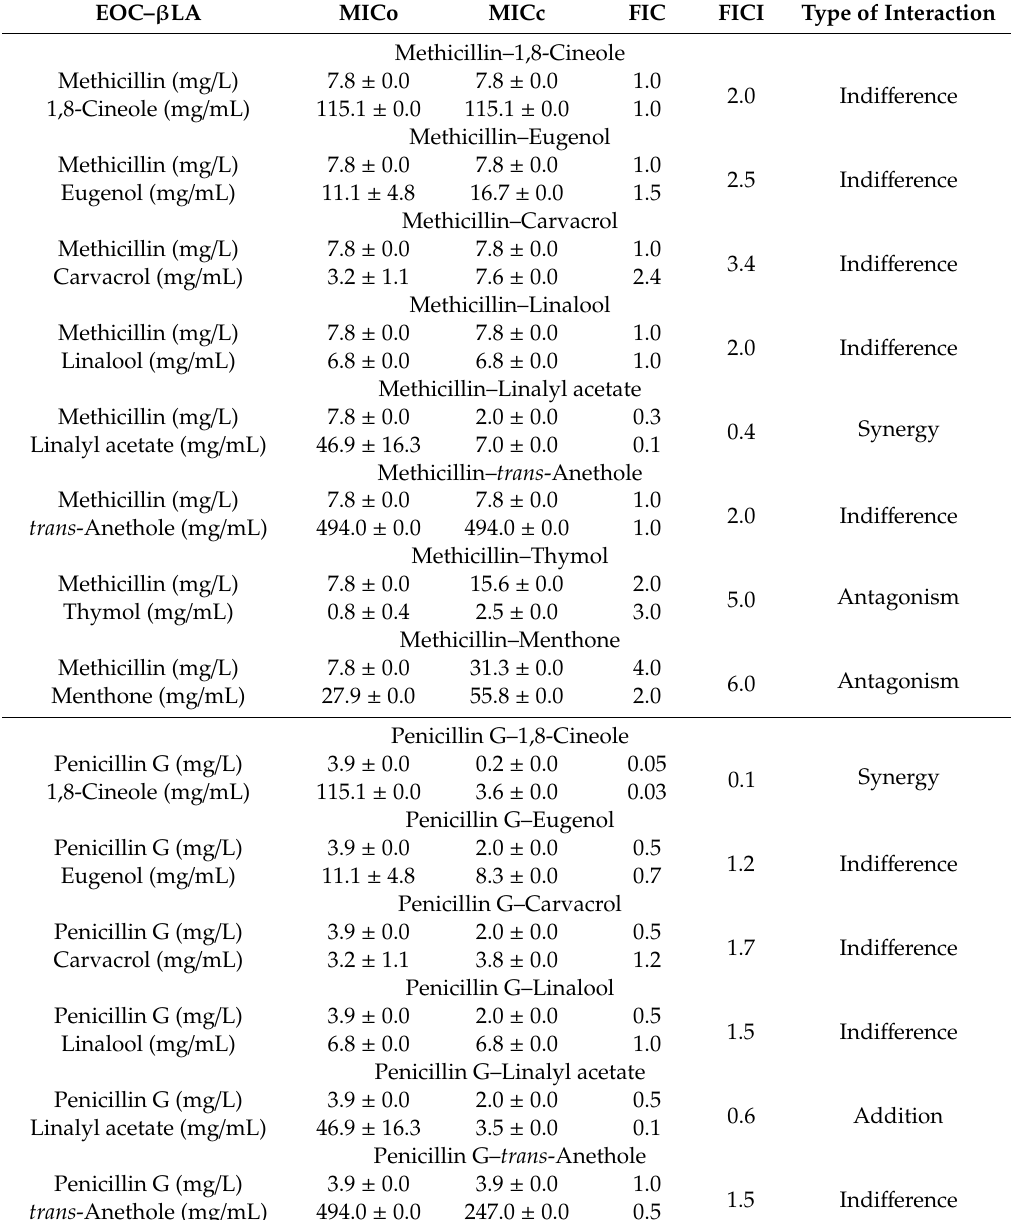
Table 2. Fractional inhibitory concentration (FIC) and FIC indices (FICIs) of pairs of essential oil compounds (EOCs) and β -lactam antibiotics ( β LAs) against Staphylococcus aureus ATCC 43300